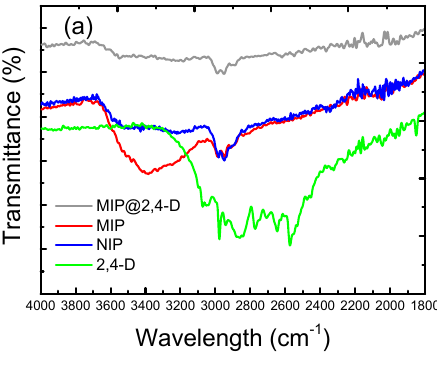
Figure 3. Particle size analysis of NIP and MIP particles: ( a , b ) SEM image of NIP; ( c ) particle size distribution of NIP; ( d , e ) SEM image of MIP; and ( f ) particle size distribution of MIP; the as-prepared MIP and NIP particles was examined after coating with Au/Pd.